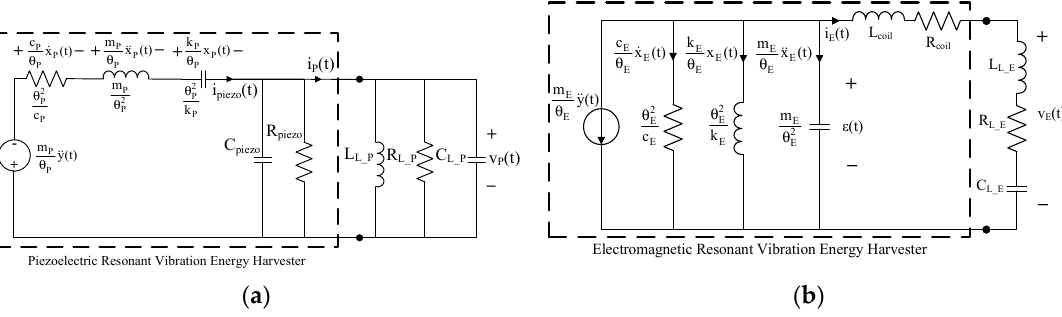
Figure 4. ( a ) Equivalent electric circuit of P-RVEHs. ( b ) Equivalent electric circuit of E-RVEH.